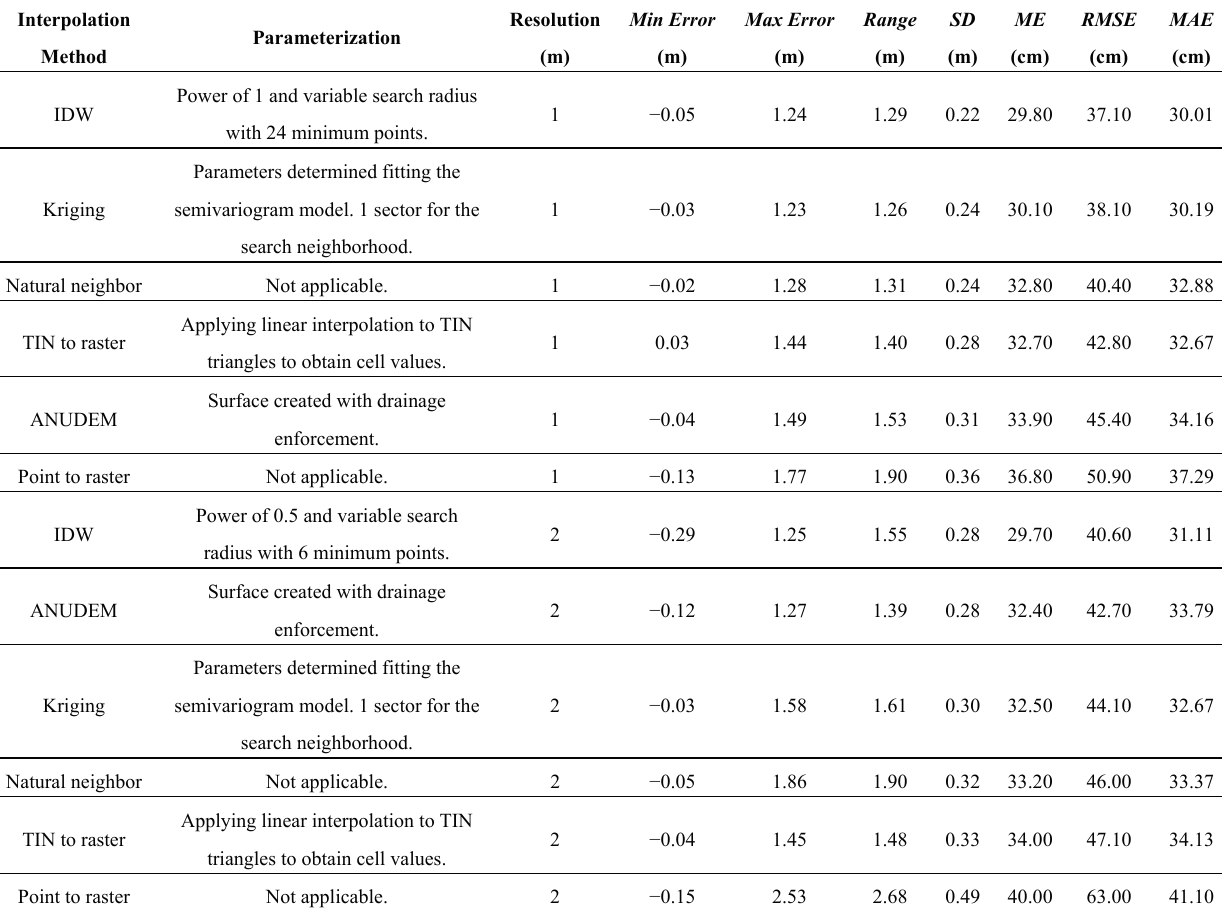
Table 4. Global statistics summarizing validation errors using the GPS benchmarks. Only the most accurate parameterization values for all the methods applied at both resolutions (1 m and 2 m) are analyzed. Mean Error ( ME ), Mean Absolute Error ( MAE ), Root Mean Square Error ( RMSE ) and Standard Deviation of residuals ( SD ). Interpolation methods are ranked from lowest to highest RMSE . N =